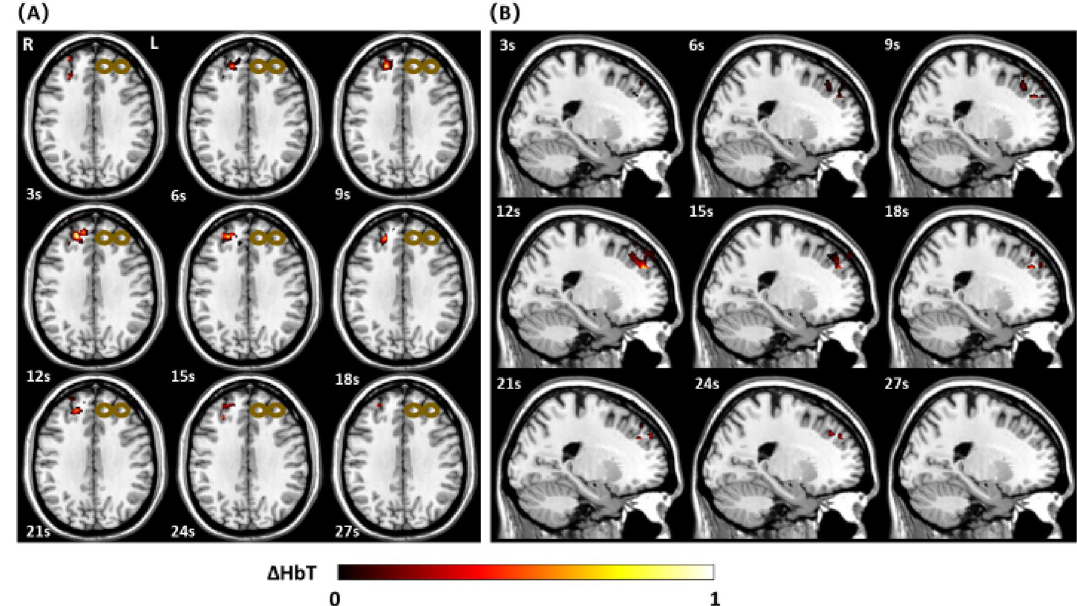
Figure 4. ( A ) Transverse view of the three-dimensional [HbT] images collected by DOT in a healthy subject during a 30 s epoch. ( B ) Sagittal view of the three-dimensional [HbT] images collected by DOT in a healthy subject during a 30 s epoch. Data was only acquired from the right hemisphere of the brain. The bronze colored coil symbol represents stimulation of the left side.